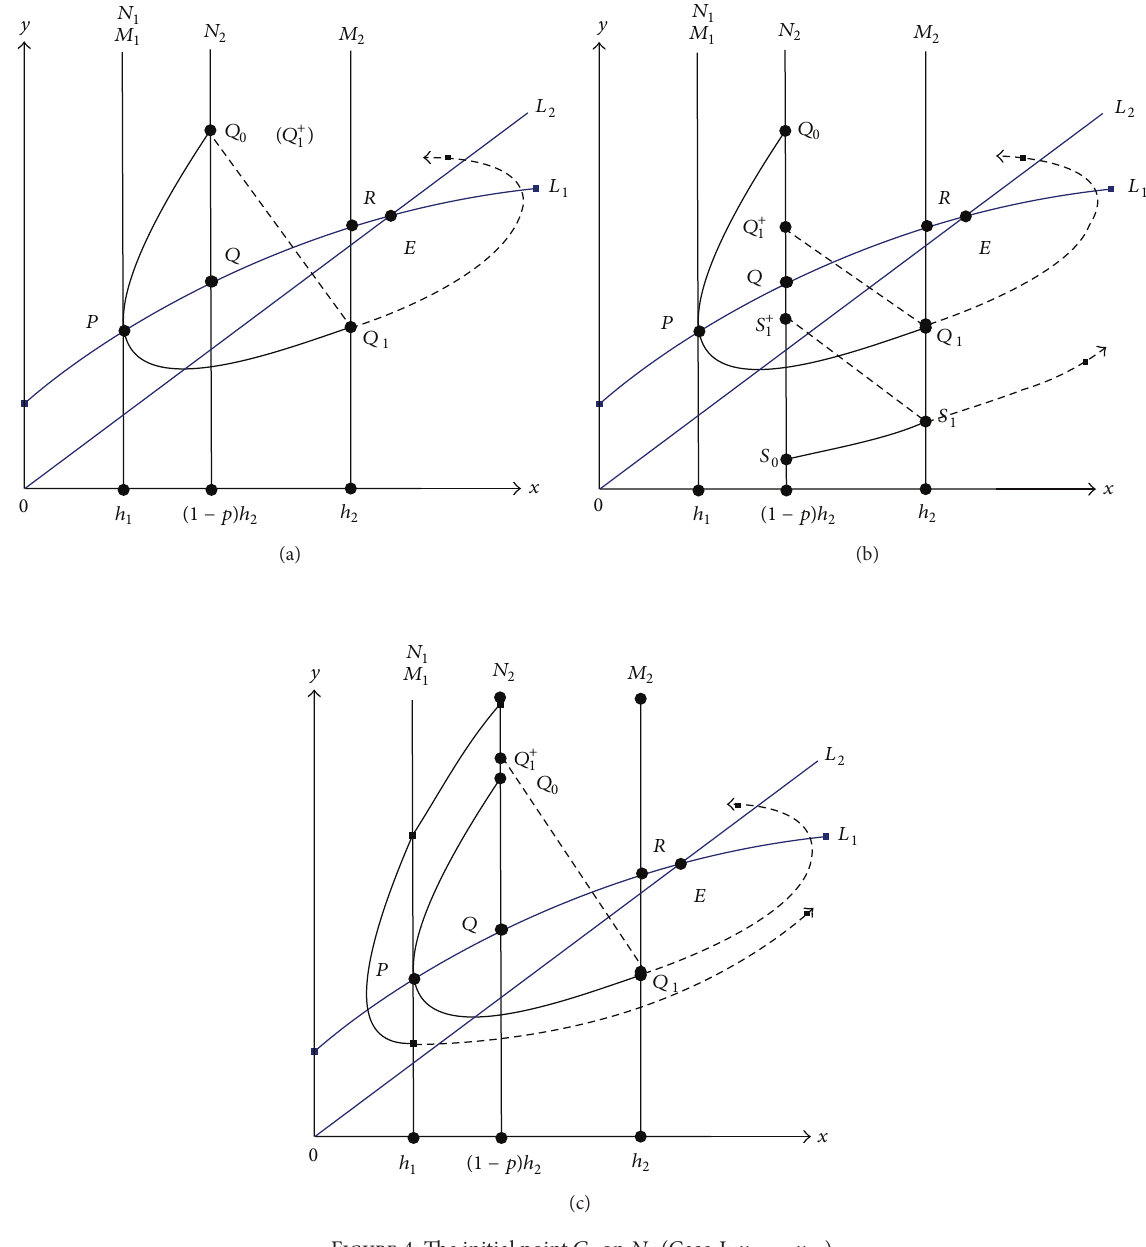
Figure 4: The initial point 𝐶 0 on 𝑁 2 (Case I: 𝑦 𝐶